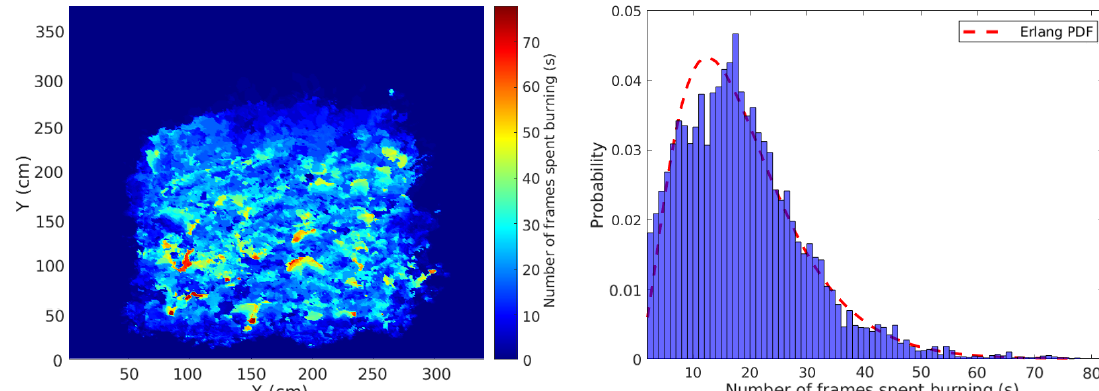
Figure 16. ( Left ): The number of frames each pixel spent between the ignition temperature and the maximum temperature. Since the frame rate is 1 Hz, the color also represents the number of seconds each cell spends burning. ( Right ): The burn time distribution with mean µ = 18.5 s, standard deviation σ = 11.1 s, and kurtosis κ = 5.2. The red curve is an Erlang distribution with shape parameter k = 3 and rate parameter λ = 0.2 s − 1 . The normalized root mean square error between the points on the Erlang distribution curve and the data is 3.2 × 10 − 3